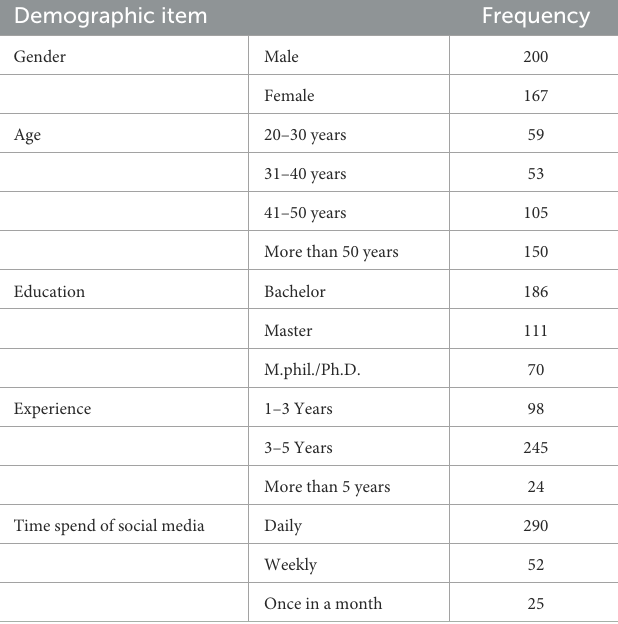
TABLE 1 Demographic profile of the